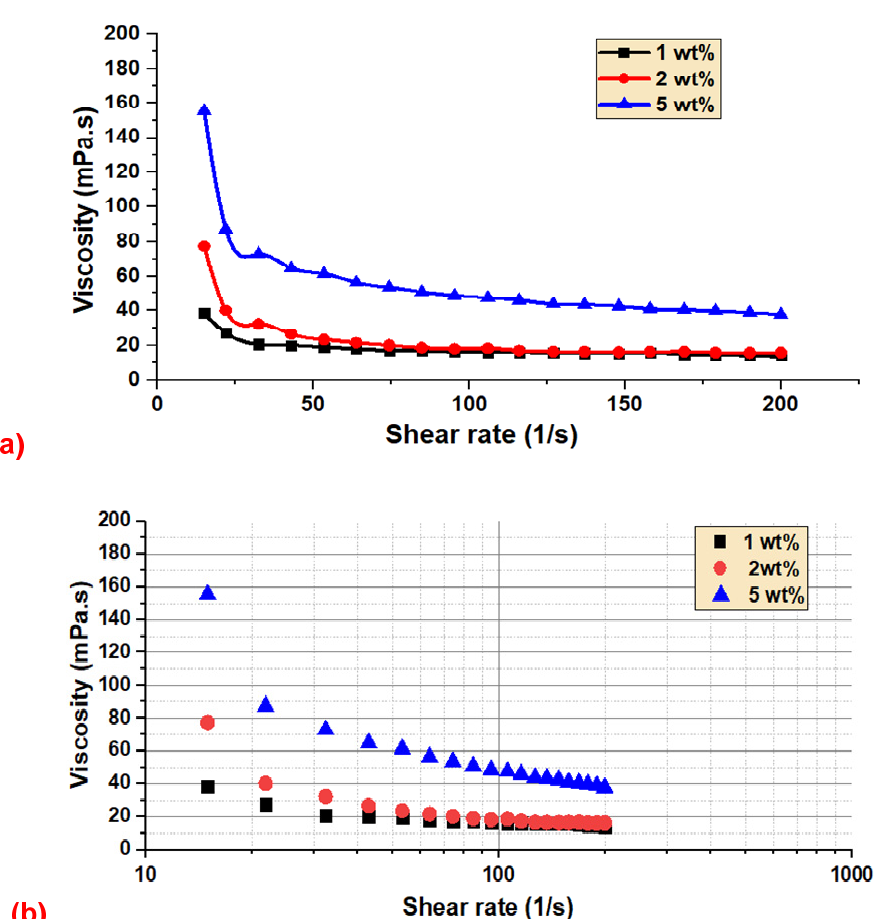
Figure 6. Effect of concentration on viscosity under shear rates at 55 ◦ C. ( a ) viscosity vs. shear rate for different okra concentrations; ( b ) traditional polymer flow curves report the presence of three regions (Region I, Region II, Region III). At low shear rates, semi-linear trends or constant plateaus are usually observed to indicate a Newtonian re-gion known as Region I, where the shear rates do not alter the polymer viscosity. In the current findings region was not seen. This might be at-tributed to the fact that Region I occurs at low shear rates due to the coherent motion of